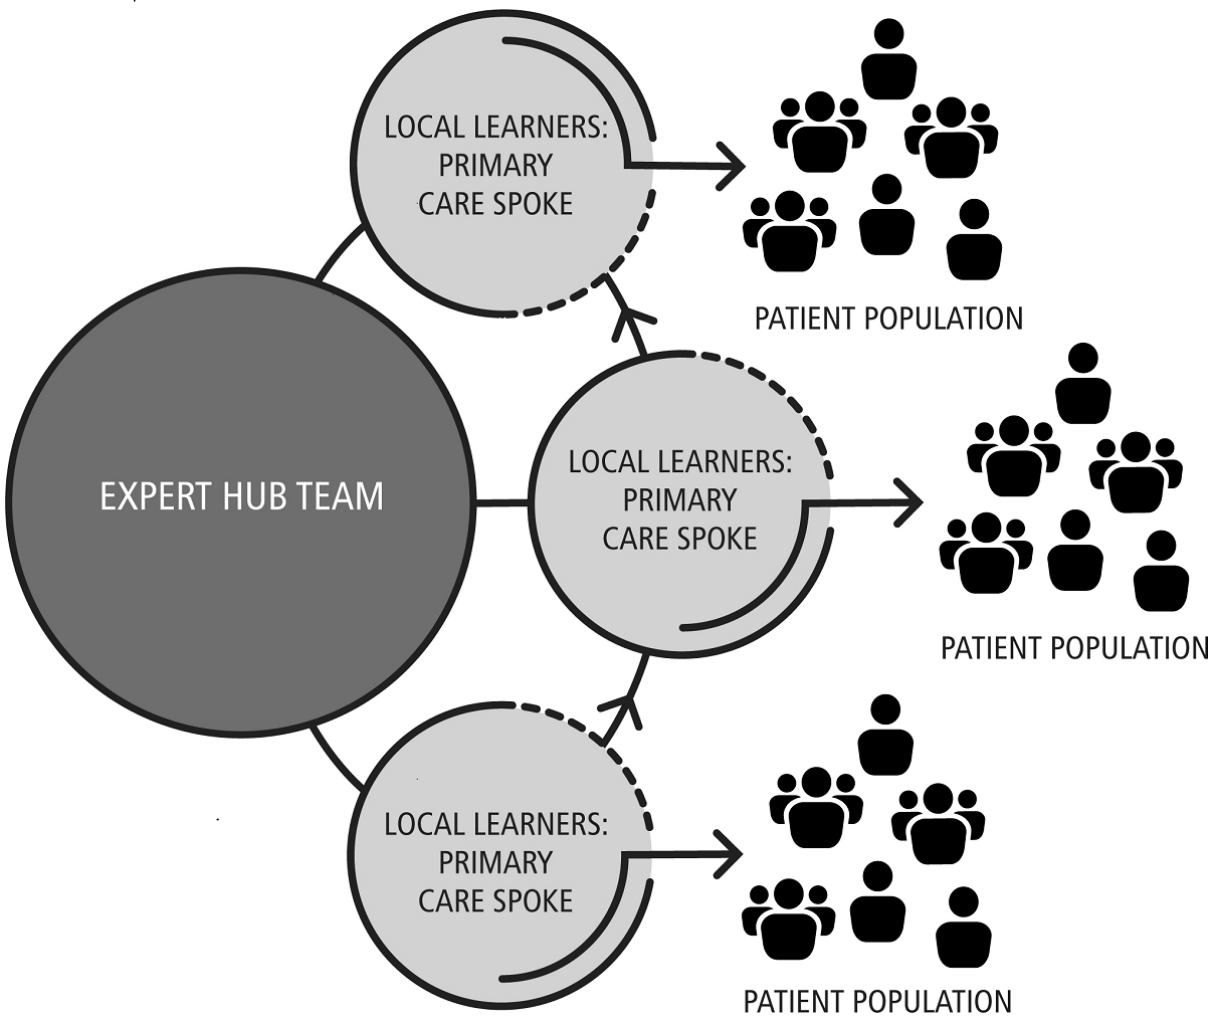
Figure 1. The ECHO model uses a hub and spoke model to create an all-teach, all-learn environment. The more providers that are trained, the more patients that are